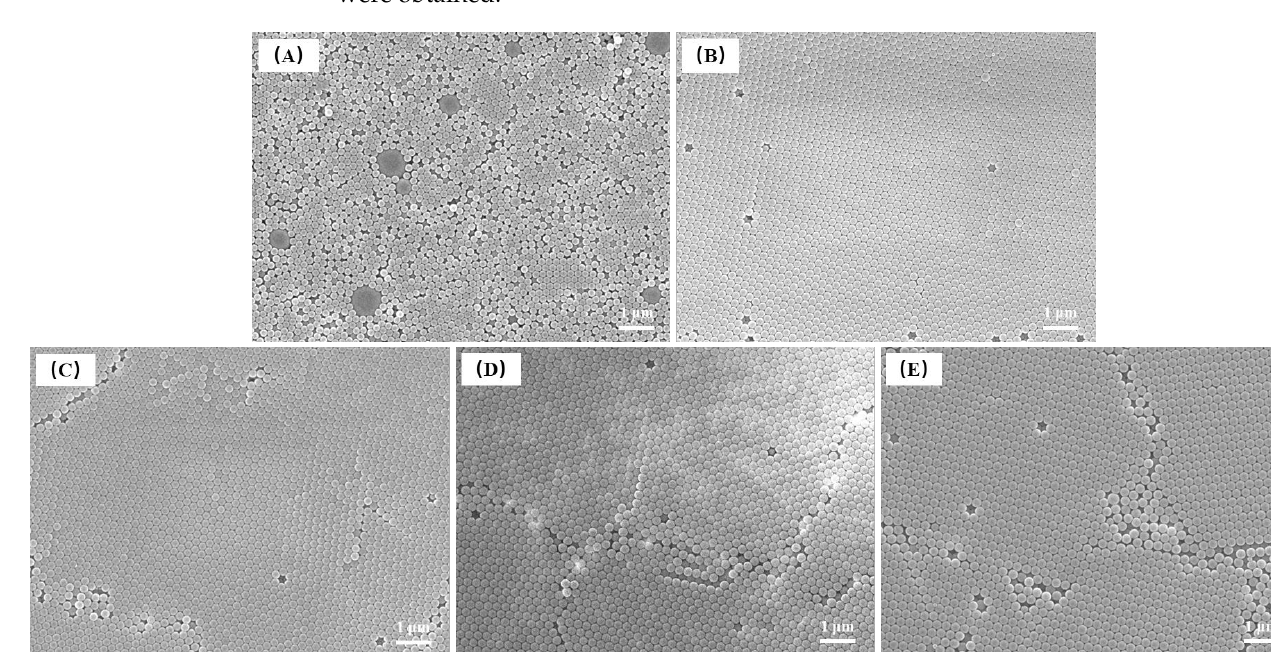
Figure 11. FE-SEM images of P(St-AA) colloidal microspheres synthesized with different reaction temperatures: ( A ) 65 °C; ( B ) 70 °C; ( C ) 75 °C; ( D ) 80 °C; ( E ) 85 °C.